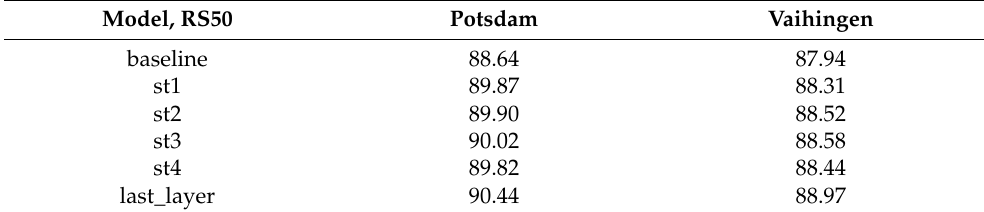
Table 2. Precision comparison (OA, %) of networks with embedding a DNL block into different positions of the encoder–decoder architecture.